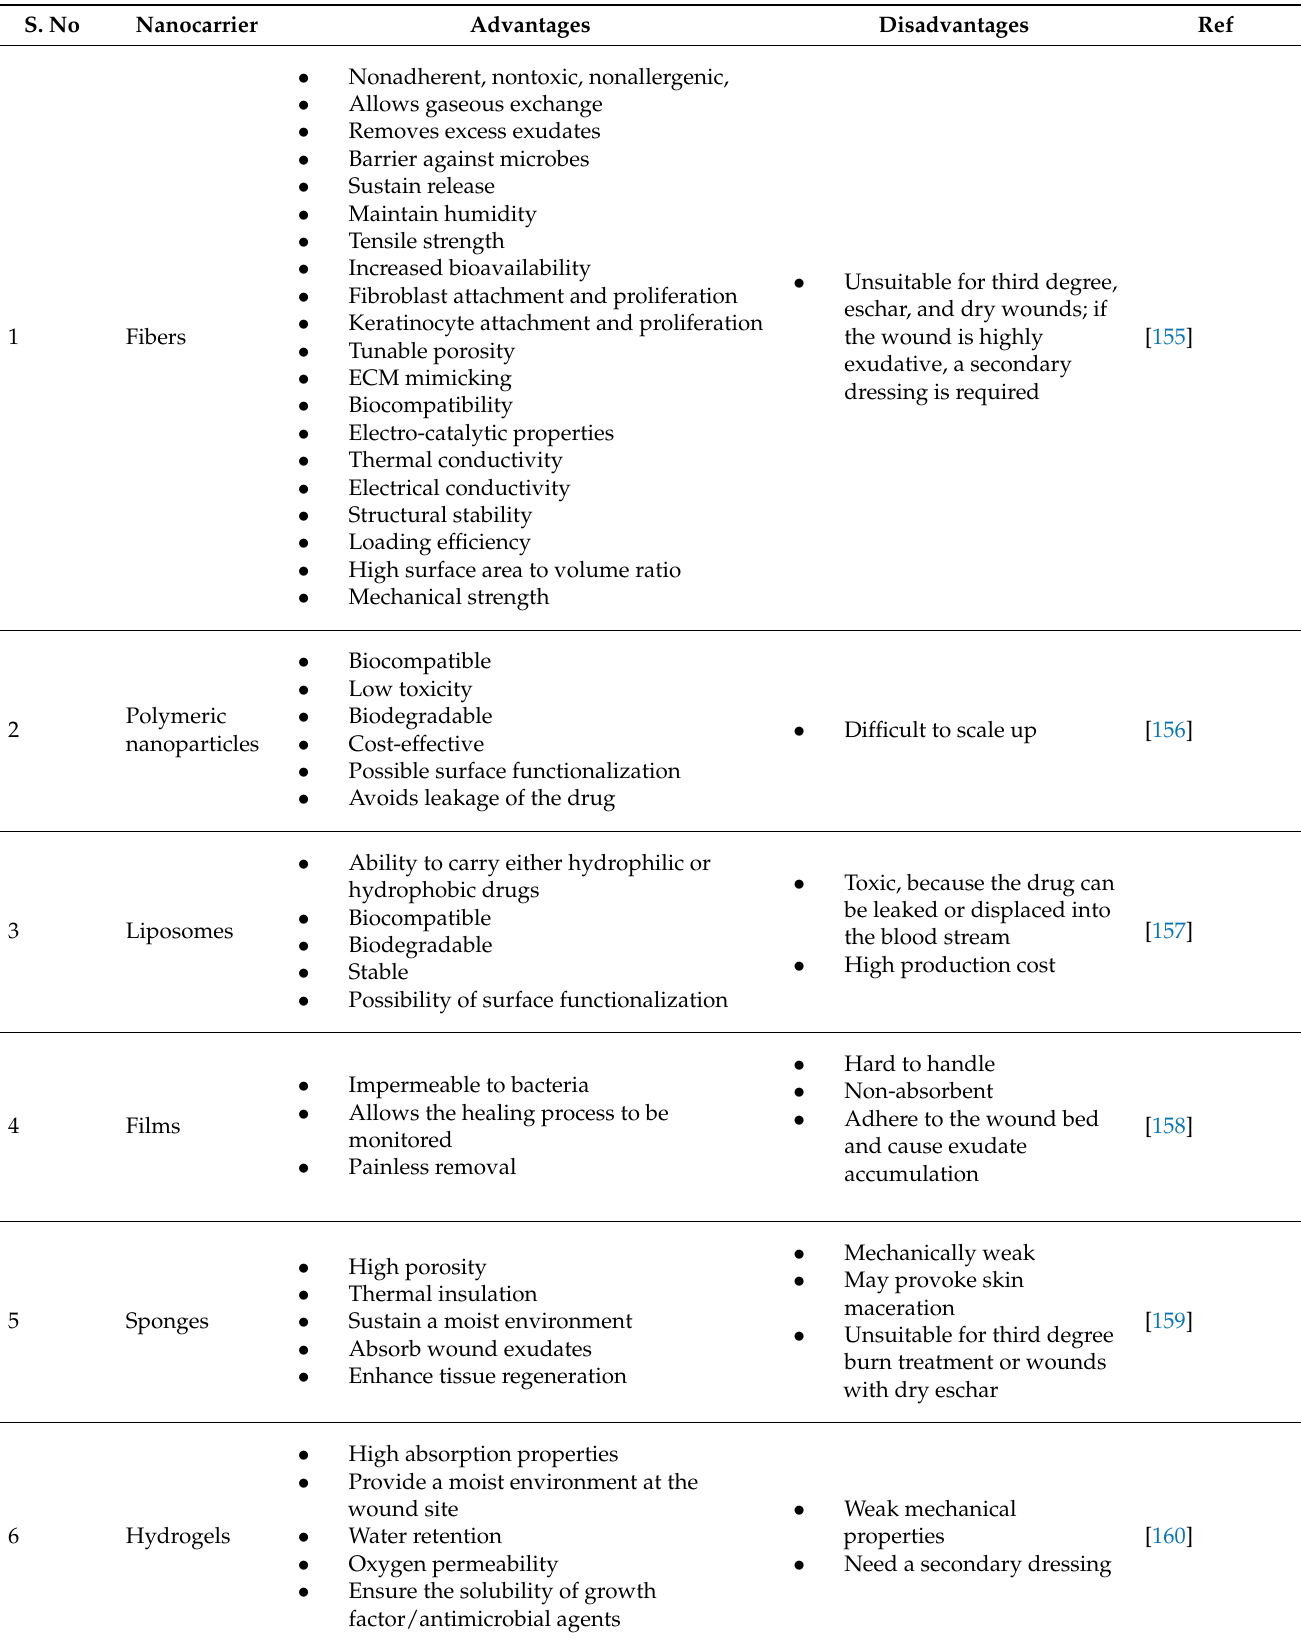
Table 4. The benefits and drawbacks of the various types of nanocarriers. S.